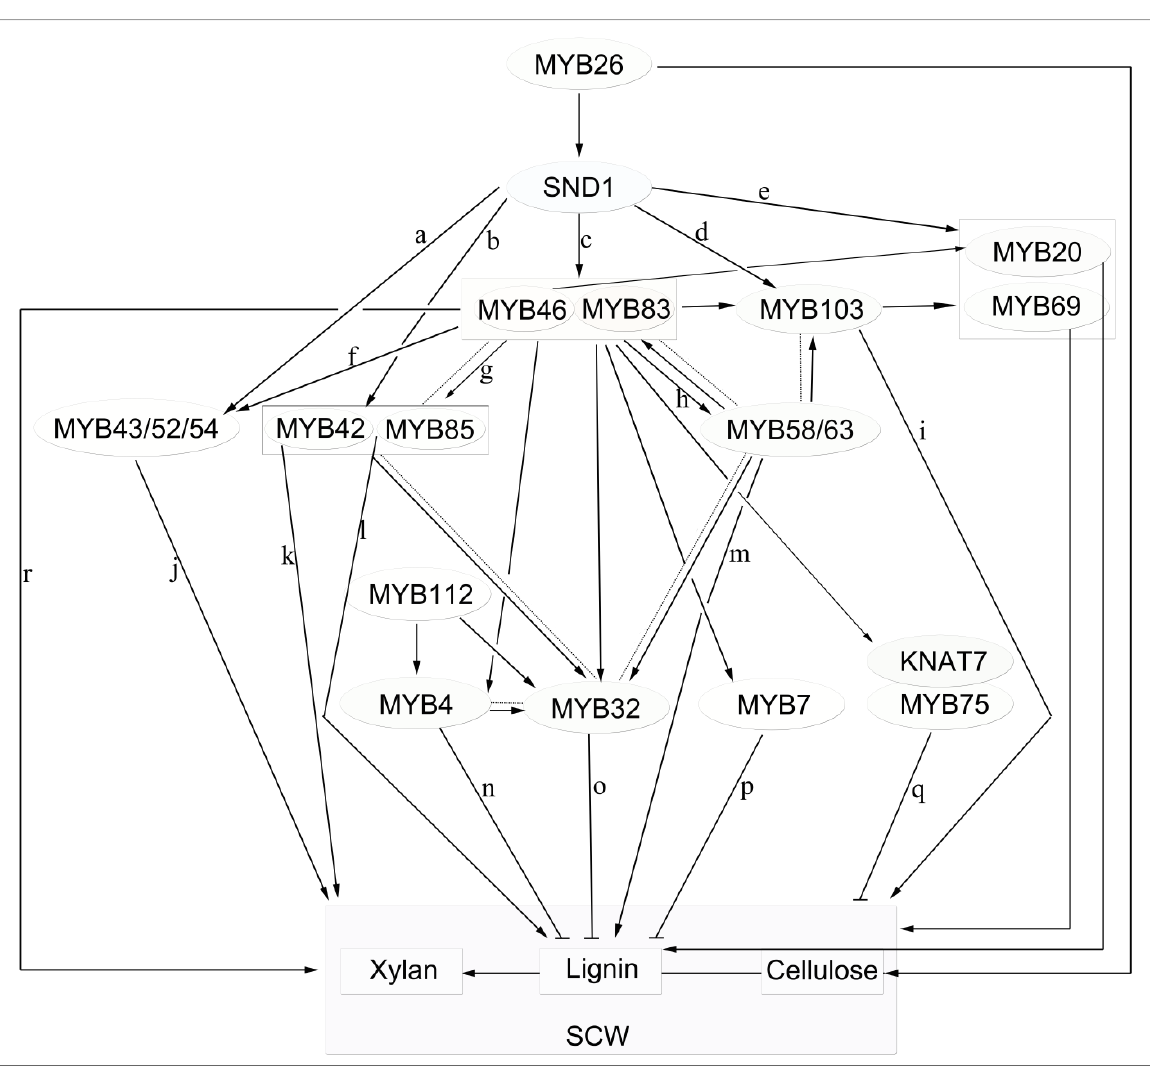
Figure 3. Proposed model of MYB-mediated secondary cell wall (SCW) regulation in Arabidopsis . Solid black and flat- headed arrows represent positive and negative transcriptional regulation, respectively. Dashed lines represent co-expression relationships, MYB26 and SND1, MYB46/83, and other TFs represent the first, second, and third layers of the transcriptional regulatory network, respectively. The expression of 9 SND1-regulated transcription factors, namely, MYB20, MYB42, MYB43, MYB52, MYB54, MYB69, MYB85, MYB103, was developmentally associated with cells undergoing secondary wall thickening (a, b, c, d, e; [72]). MYB46 and MYB83 serve as the second layer of the main switch for secondary cell wall biosynthesis, which activate downstream transcription factors (including MYB20, MYB42, MYB43 and MYB85) by binding to SMRE sequence in an SCW MYB-responsive element (f, g, h, r; [101,103]) and directly or indirectly regulate the biosynthesis of the secondary wall. MYB42, MYB43, MYB85 (j, k, l; [109]), MYB58, MYB63 (m; [110]), MYB103 (i; [37]) are transcriptional regulators that directly activate lignin biosynthesis genes during secondary wall formation in Arabidopsis . MYB4, MYB7, MYB32, MYB75 are inhibitors of lignin biosynthesis (n, o, p, q; [60]). The concerted actions of the MYB TFs in this network leads to a coordinated activation of SCW biosynthetic genes, which results in the synthesis of lignin, cellulose, xylan.